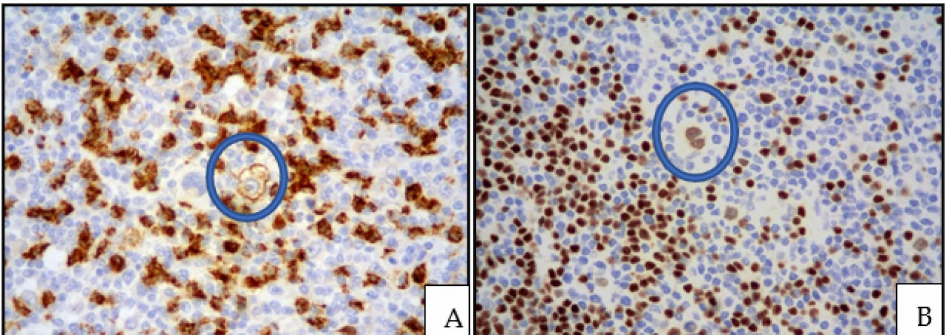
Figure 4. ( A ) cHL: CD15 expression highlighting a Hodgkin cell with membranous positivity (inside the blue circle); in the background, granulocytes are strongly CD15 positive (immunostaining, magnification 400 × ; original image from Prof S.A.); ( B ) cHL: weak PAX5 positivity of a Hodgkin cell, inside the blue circle; unlike Hodgkin cells, B lymphocytes strongly express PAX5 (immunostaining, magnification 400 × ; original image from Prof S.A.).